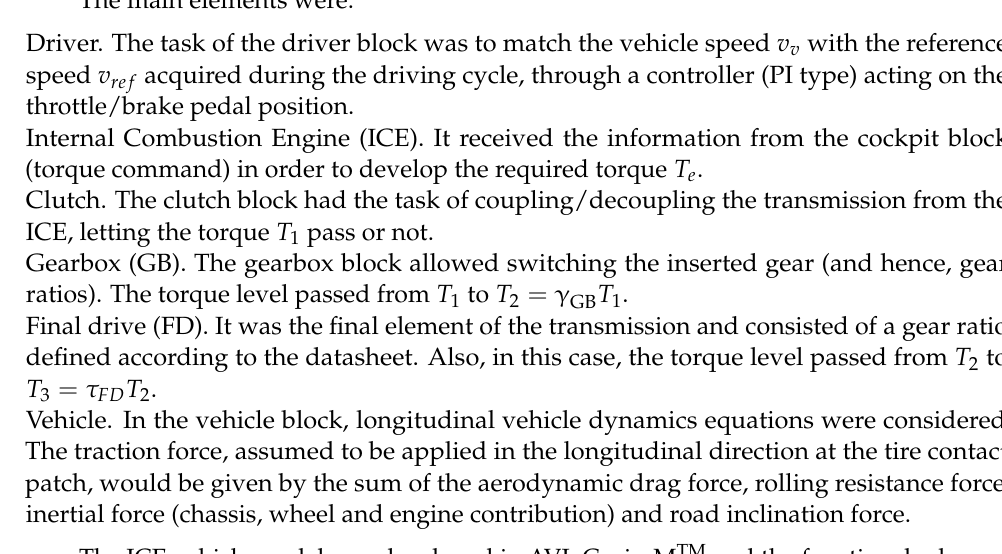
Figure 8. HEV feed-forward model scheme. B: battery, C: control unit E: engine, EM: electric motor/generator, P: power converter, U : voltage, I : current, T : torque, 𝜔 : rotational speed, 𝛾 (cid:3008)(cid:3003) : gearbox gear ratio 𝑣 (cid:3045)(cid:3032)(cid:3033) : reference speed, 𝑣 (cid:3049) : vehicle speed. Figure 9 shows the HEV model developed in AVL CruiseM TM .